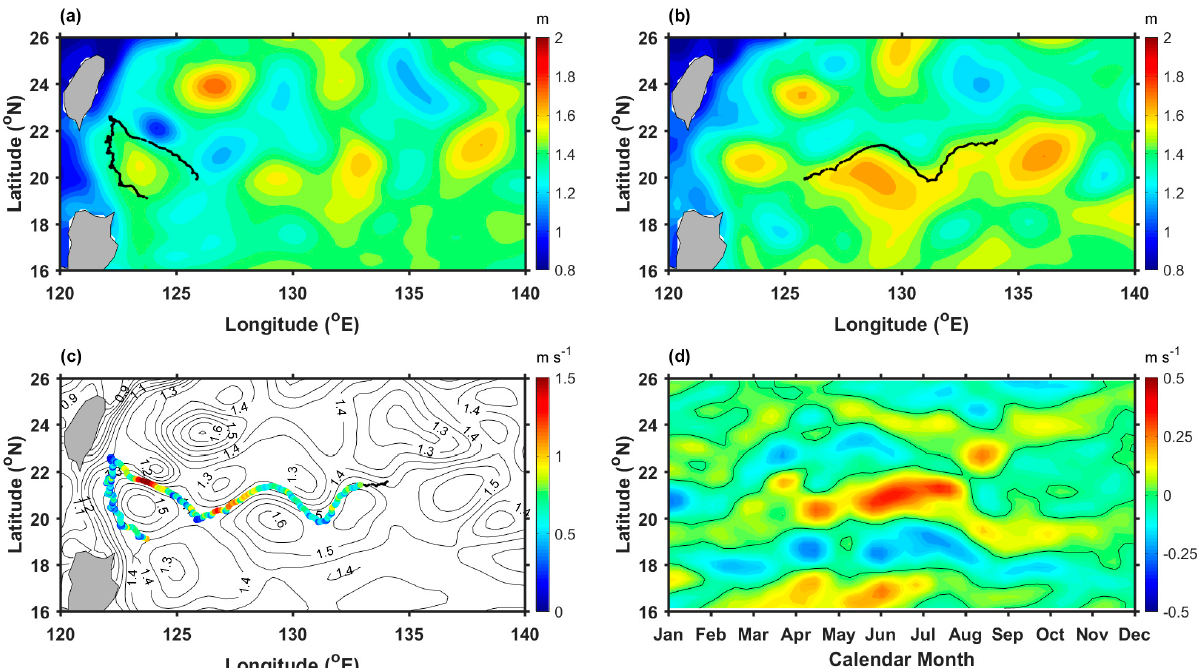
Figure 4. Spatial distribution of satellite-obtained absolute dynamic topography (ADT) averaged in ( a ) May, ( b ) June, and ( c ) from May to June (contours, units in m), in 2010, based on the altimetry 1/4 ◦ -gridded product. The black curve in ( a , b ) shows the trajectory of drifter 22527 in the relative month. The colored curve in ( c ) shows the drifter-measured current speed along the trajectory. ( d ) Hovmöller diagram of zonal geostrophic-current velocity averaged within 125 ◦ and 135 ◦ E, with the zero values of zonal geostrophic velocity shown by the thin